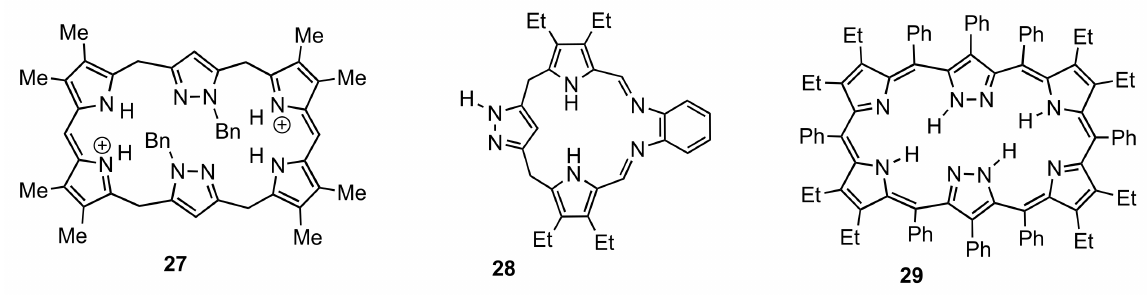
Figure 2. Expanded pyrazole-containing porphyrinoids.